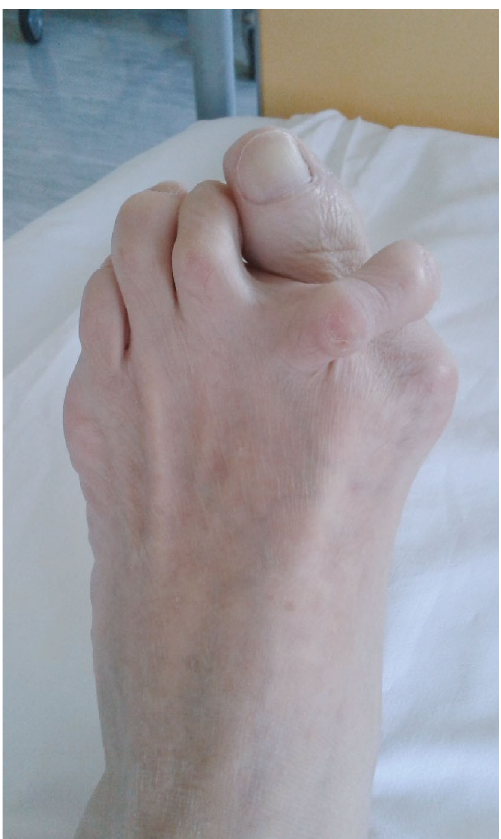
Figure 1: Photograph of the patient ’ s left foot before the